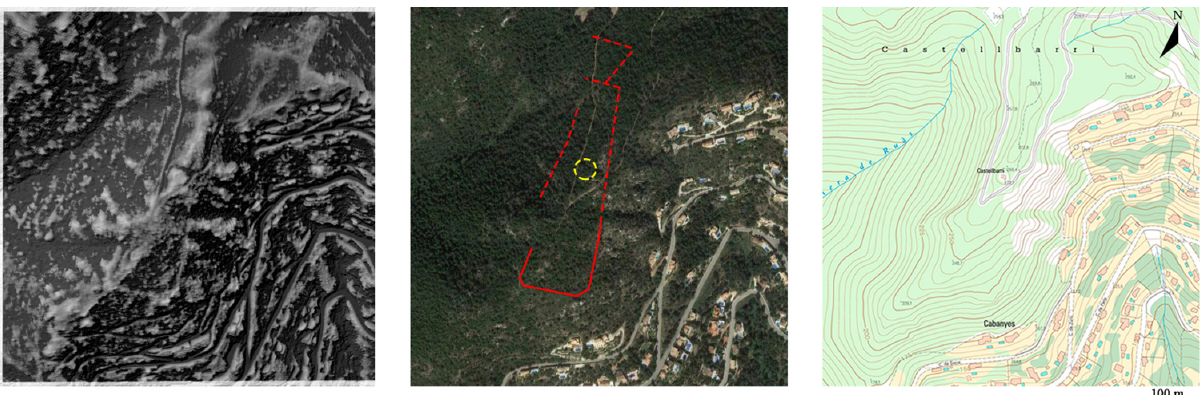
Figure 9. MSRM ( left ), satellite view ( centre ) and topographic map ( right , forest in green) of the Torre Roja site. In the satellite image the walls (red) and the known location of the settlement (yel- low) are indicated.